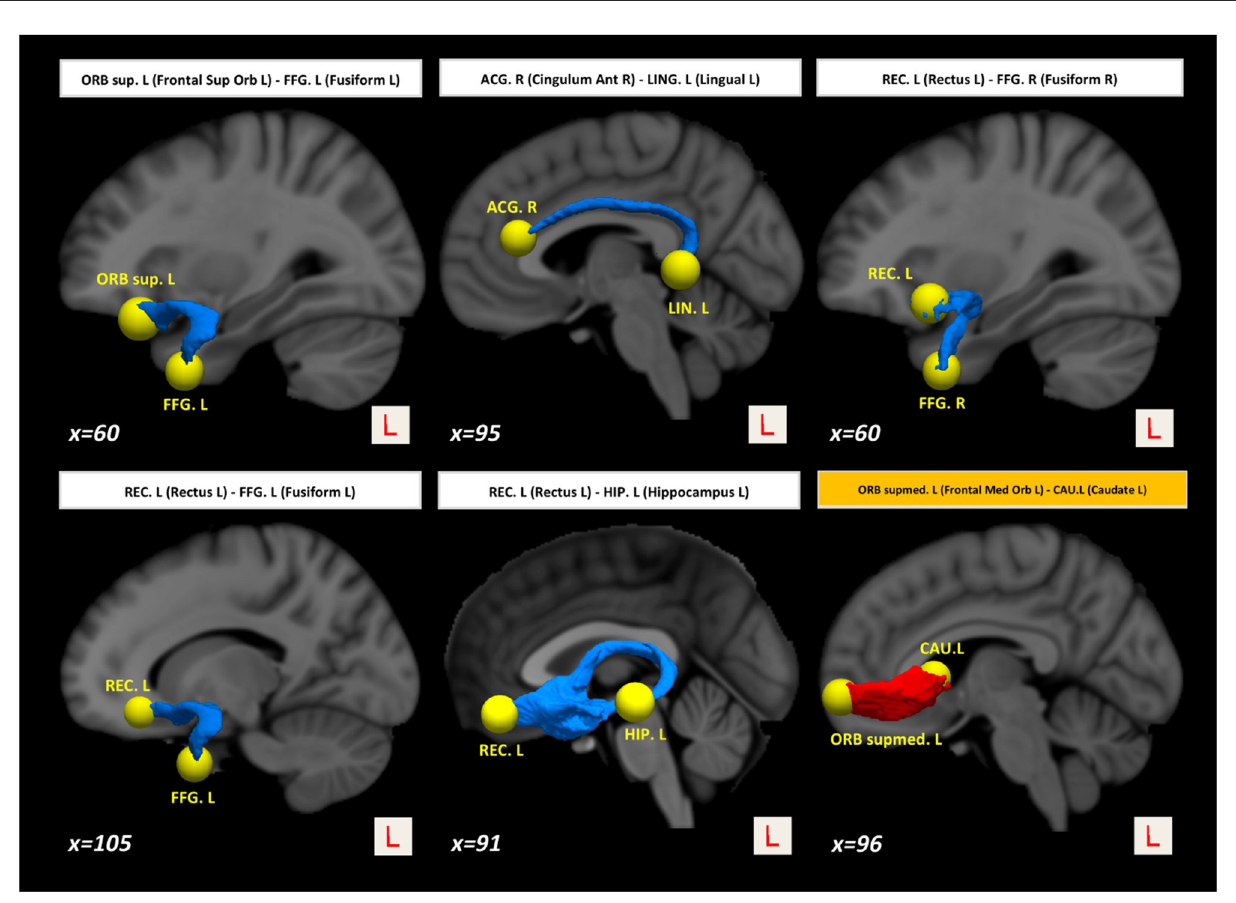
FIGURE2 Tract reconstructions corresponding to structural connectivity differences between HC and PD at baseline. The tracts were reconstructed by connectome2tck (MRtrix3) in the native space for all HC subjects, converted to track-weighted image by tckmap (MRtrix3), and normalized and averaged in the MNI 1mm standard space. For the visualization, Trackvis software (https://www.trackvis.org) was used. The blue tracts show higher connectivity in HC than PD. The red tracts show higher connectivity in PD than HC.